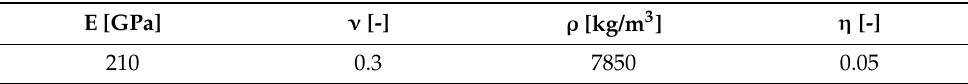
Table 1. Steel physical